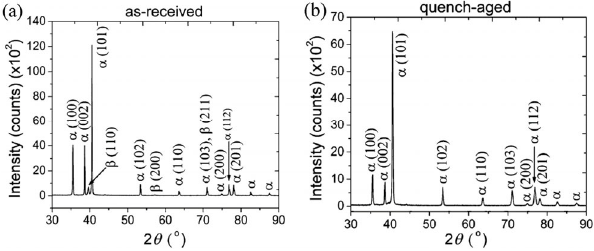
Fig. 5 XRD patterns of the characterized Ti64 surfaces: (a) as-received; (b) quenched-aged. Reproduced with permission from Ref. [61]. Copyright Springer Nature,